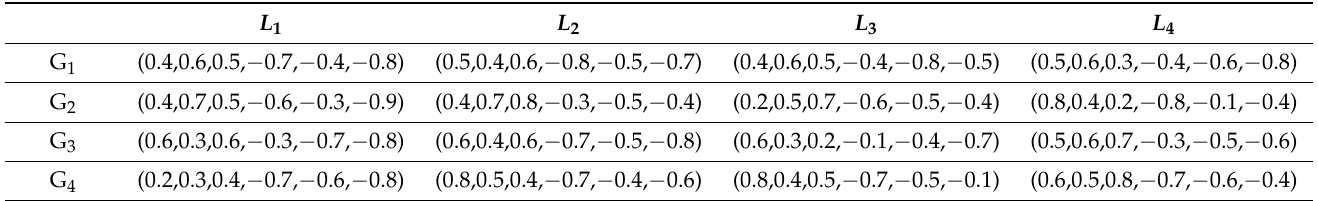
Table 2. BN decision matrix by decision-maker D 2 .